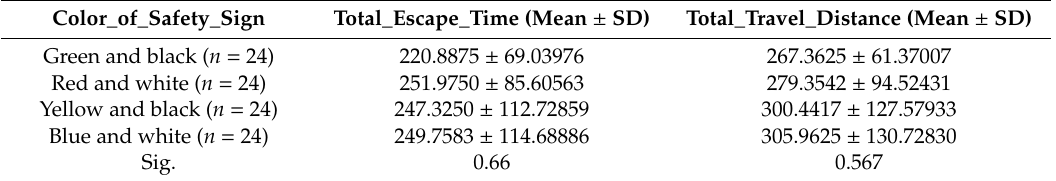
Table 4. One-WayANOVAofparticipants’escapeperformance(GroupingVariable: Color_of_safety_sign).